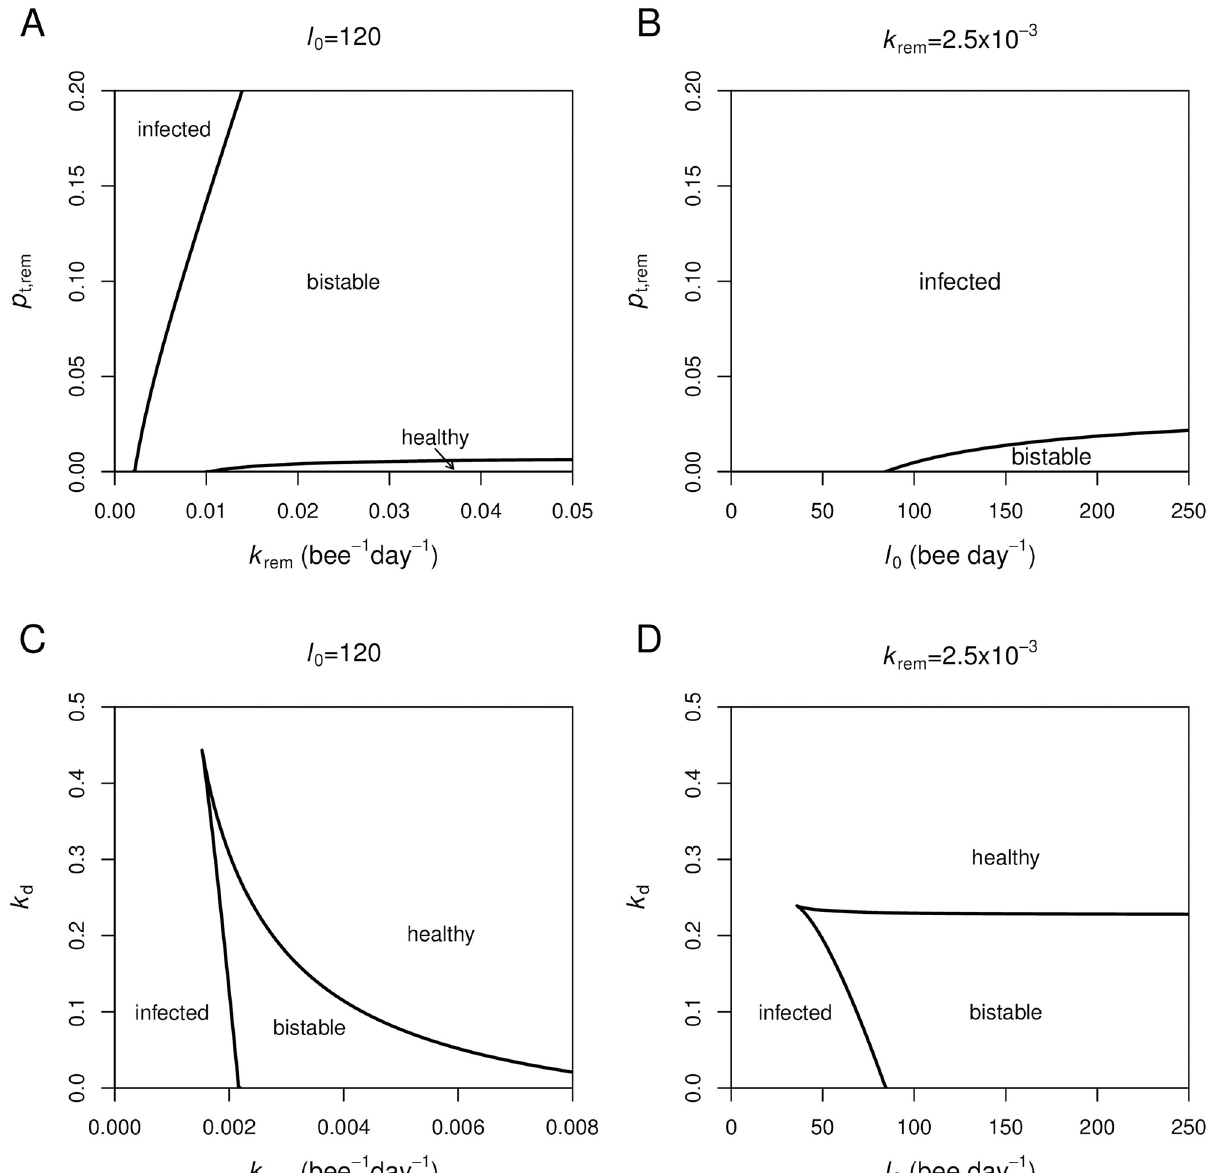
Fig 4. Role of the probability of nurses being infected from infected brood ( p t,rem ) and the death rate of infected bees ( k d ). The two-parameter bifurcation diagrams are plotted between A: k rem and p t,rem , B: l 0 and p t,rem , C: k rem and k d , and D: l 0 and k d . The diagrams are divided into regions corresponding to the state of the colony (healthy, bistable, and